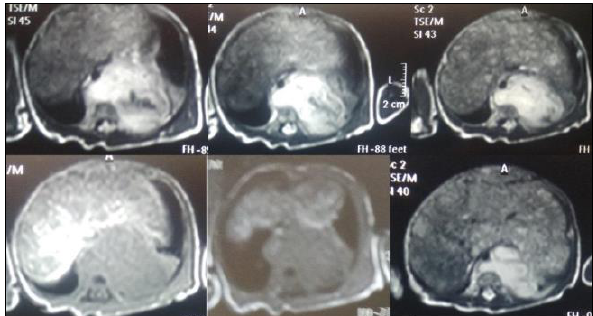
Figure 2: Photographs showing MRI abdomen (T2 transverse images) revealing left retroperitoneal, prevertebral, irregular, lobulated, hyper-intense mass, crossing the midline; mass is lifting and pushing the aorta and IVC anteriorly and extending into the posterior mediastinum. Diffuse infiltration of the liver is present (T1 transverse